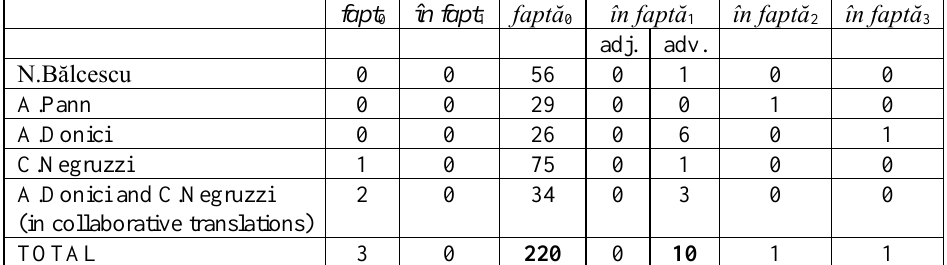
Table 1. The relationship between faptă and în faptă in early 19 th century